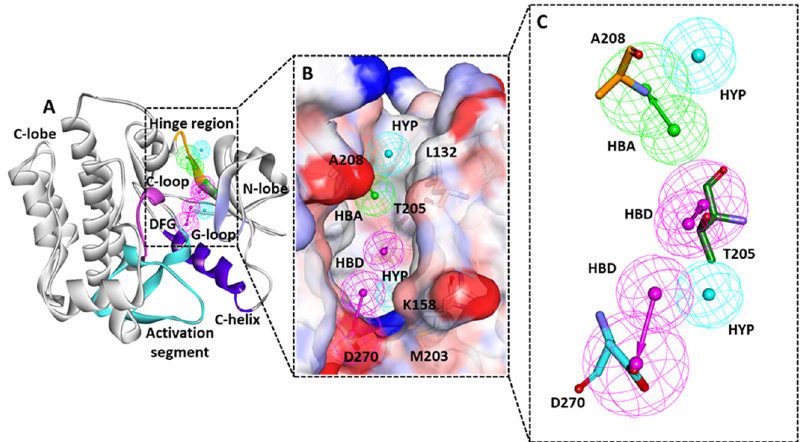
Figure 4. The ACK1 3D structure PDB:1U4D is shown here with ribbon representations. ( A ) The important regions of the ATP-binding site were shown with orange (hinge; 206–210), green (gatekeeper; T205), blue ( α C-helix; 168–183), purple (G-rich loop; 133–138), pink (catalytic loop; 251–257), and cyan color (activation segment; 270–300). ( B ) The overlay of pharmacophore inside the active site of protein is shown in A and in the surface representation. ( C ) The hydrogen bond-mapped features are shown in the enlarged view.